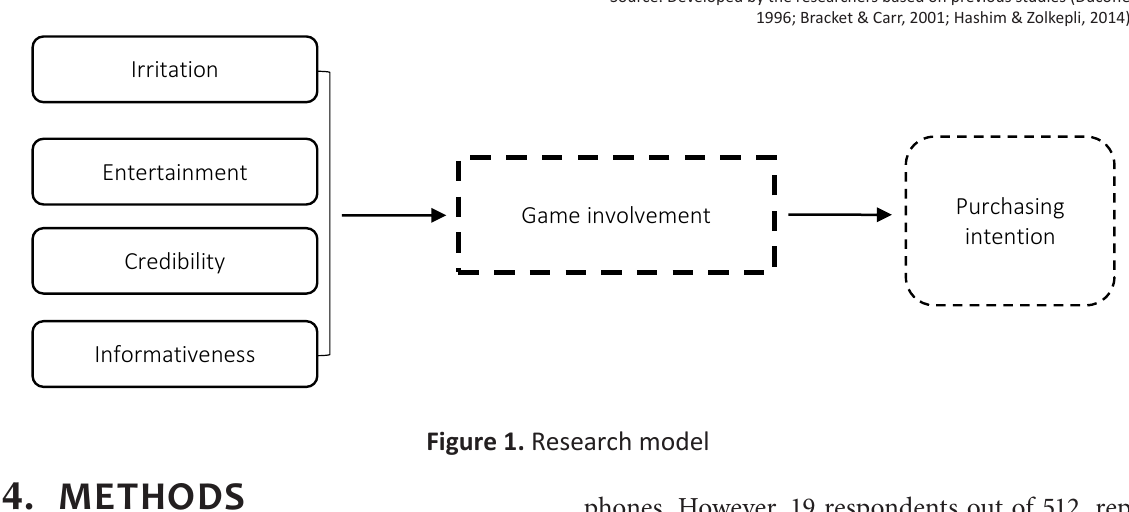
Figure 1. Research